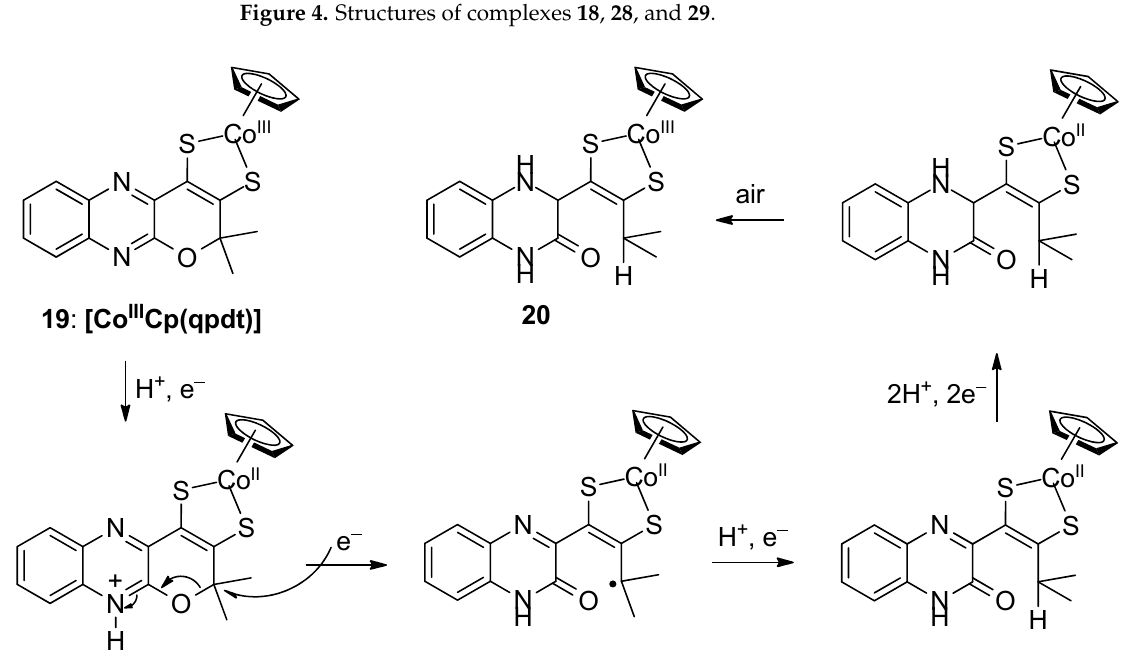
Figure 4. Structures of complexes 18 , 28 , and 29 .